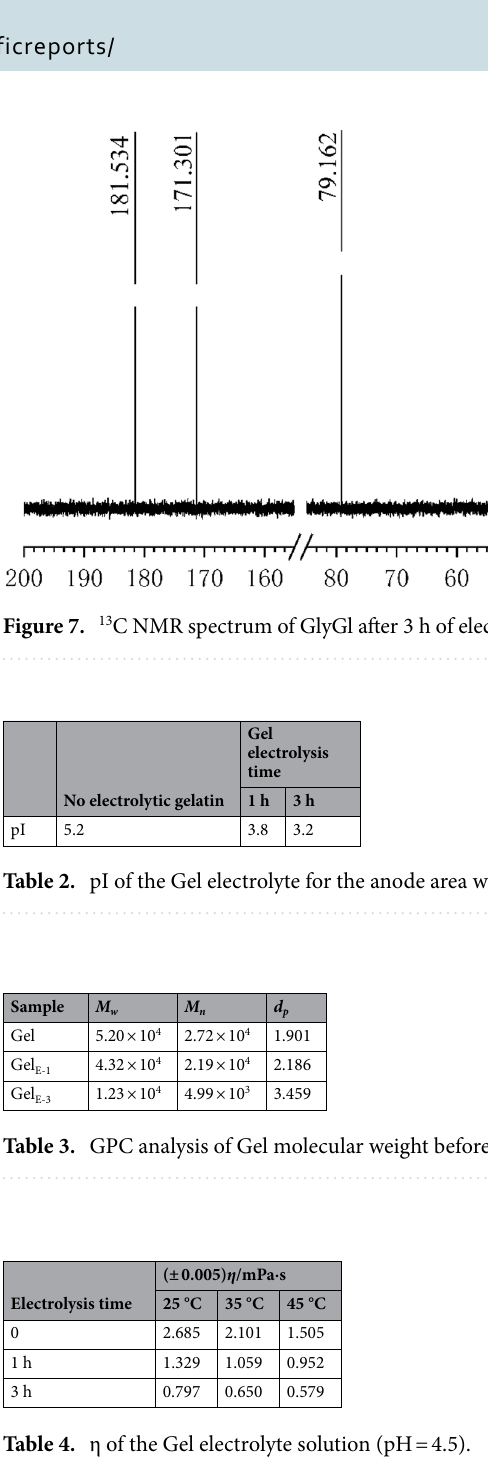
Table 4. η of the Gel electrolyte solution (pH =